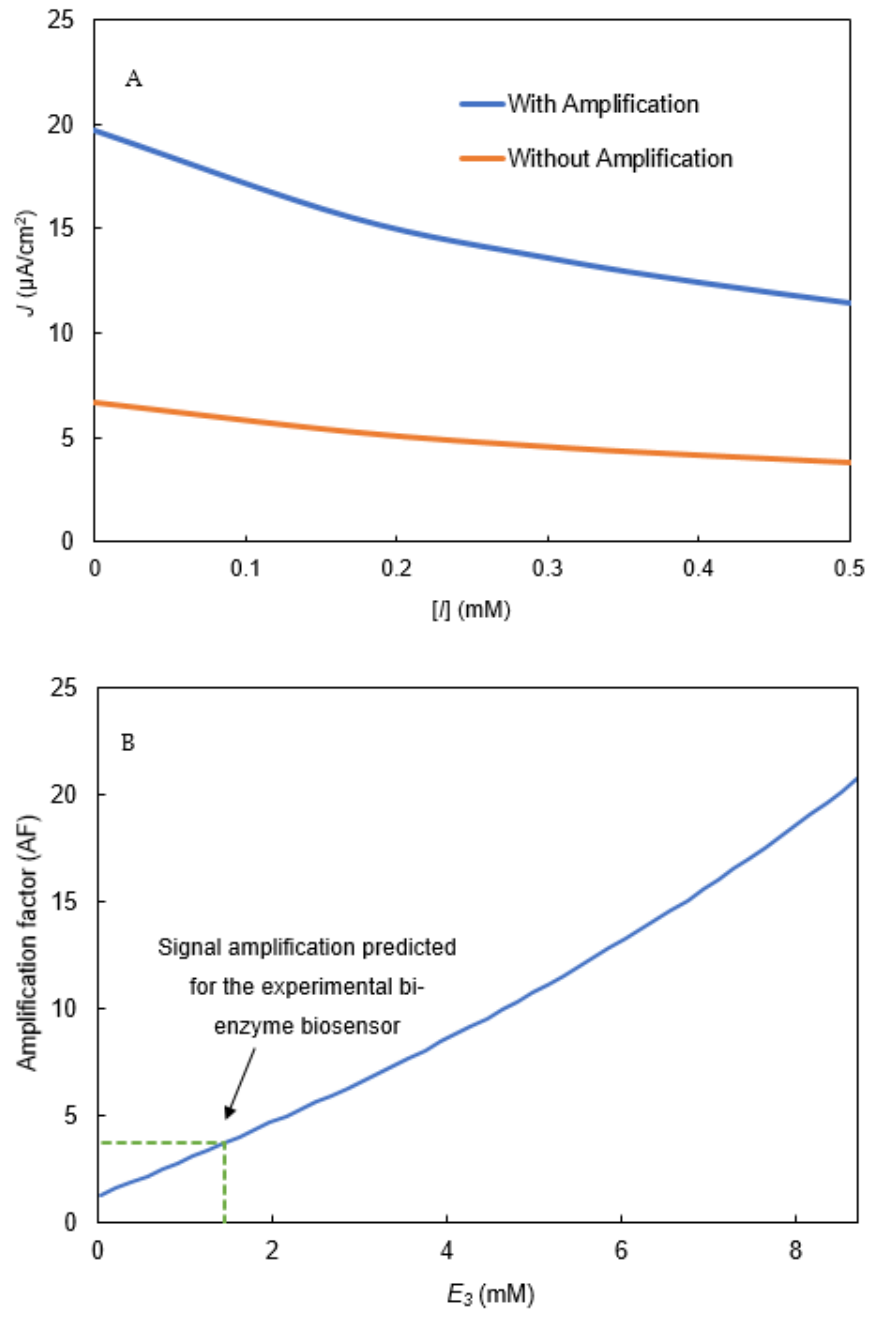
Figure 10. ( A ): Simulated current density with and without (E 3 = 0) the amplification system in the bi-enzyme biosensor. ( B ): Signal amplification in bi-enzyme biosensor due to S 3 recycling caused by catecholase activity (E 3 ).